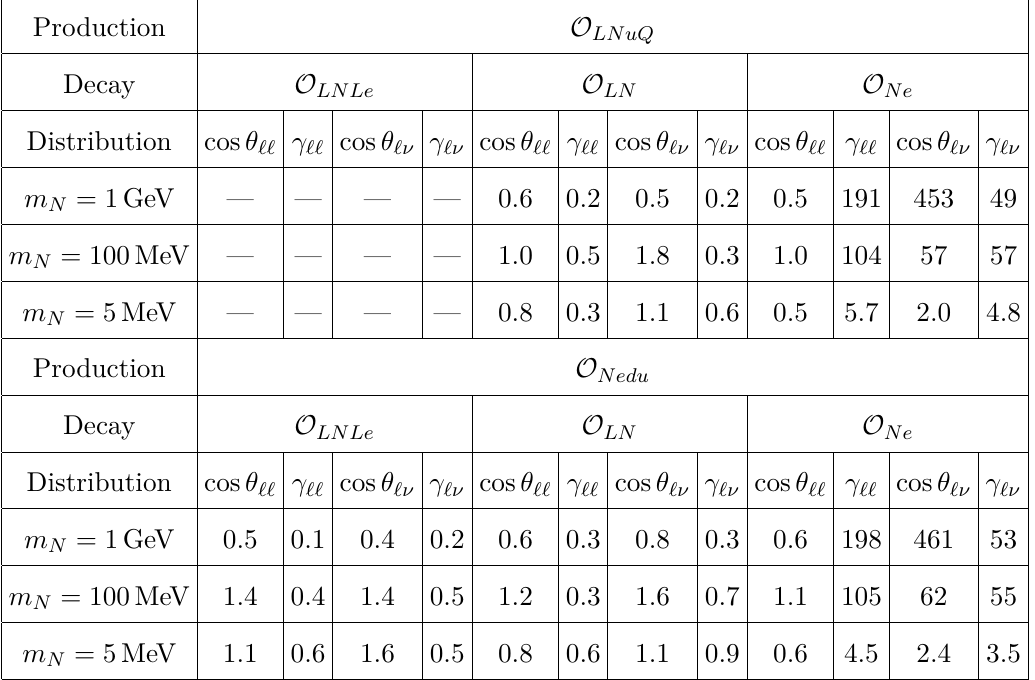
for two-body B min